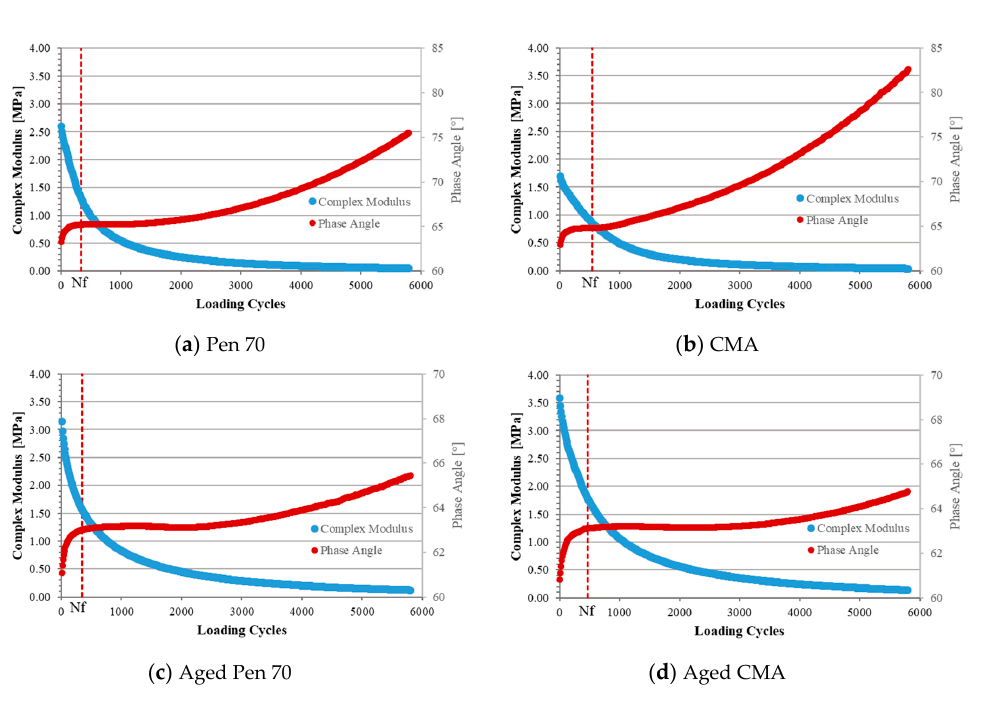
Figure 6. Results of time sweep test: ( a ) Pen 70, ( b ) CMA, ( c ) Aged Pen 70, and ( d ) Aged CMA.